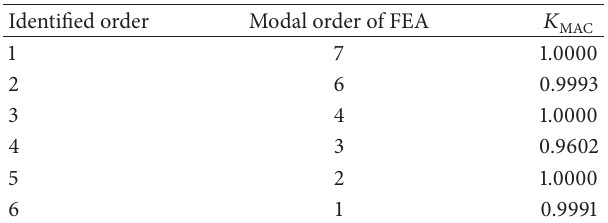
Table 11: Error of natural frequencies identified by Infomax with gradient descent method.